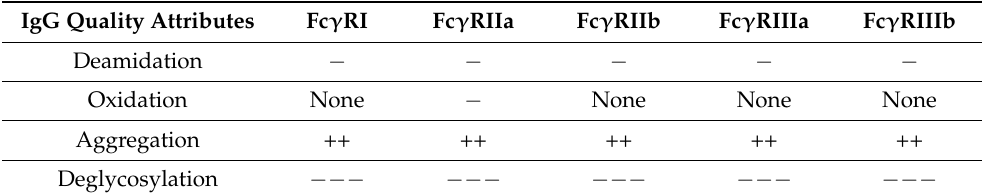
Table 1. Impact of IgG quality attributes upon binding to Fc γ